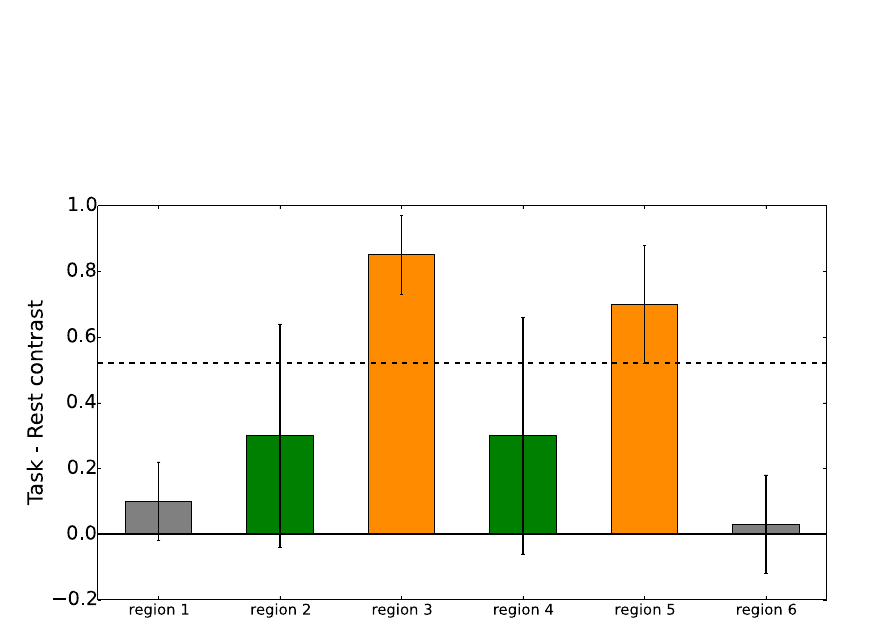
Fig. 2. An example of the in limbo approach. Shown are hypothetical contrast sizes and confidence intervals for 6 regions (these could be individual voxels). For region 1 and 6 there is no significant effect: zero falls well within the confidence intervals of the contrast size of in these regions. For region 3 and 5, there is a clear effect: the ‘‘task rest’’ contrast differs significantly from zero. For region 2 and 4 the situation is more complicated: the confidence interval of the ‘‘task rest’’ contrast still contains 0, so one is unable to reject the null hypothesis. However, the size of the contrast is not significantly different from that of the contrast in region 5. Regions 2 and 4 are ‘‘in limbo’’: they differ neither from baseline, nor from least-significantly activated region. Legend: Orange areas are significantly activated, green areas are in limbo gray areas are significantly less activated than significant